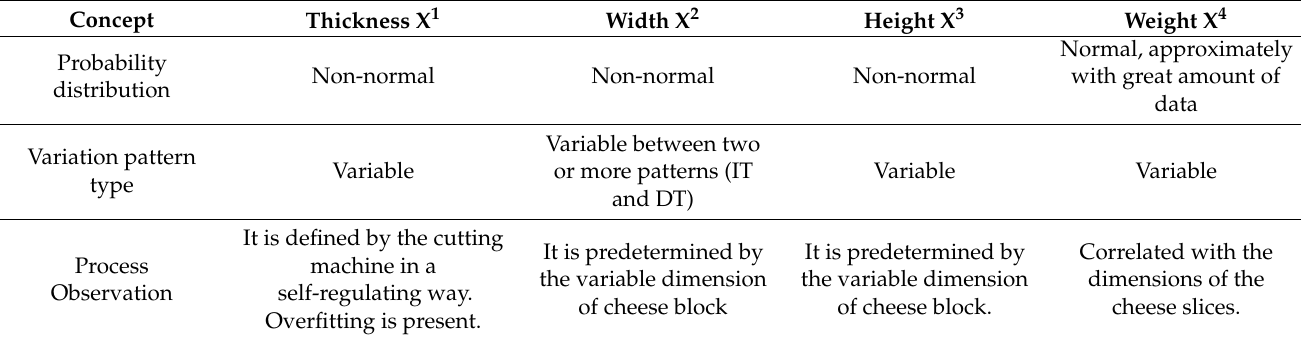
Table 1. Summary of the statistical characteristics of the random variables of the cheese